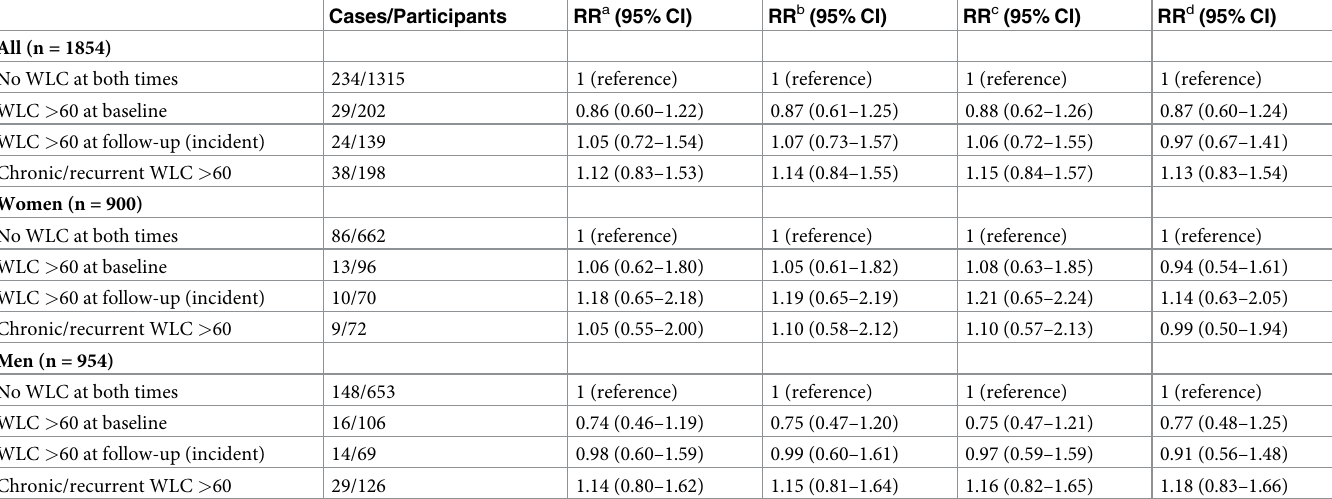
Table 3. Risk ratios (RR) and 95% confidence intervals (CI) for recurrent WLC and incident hypertension.